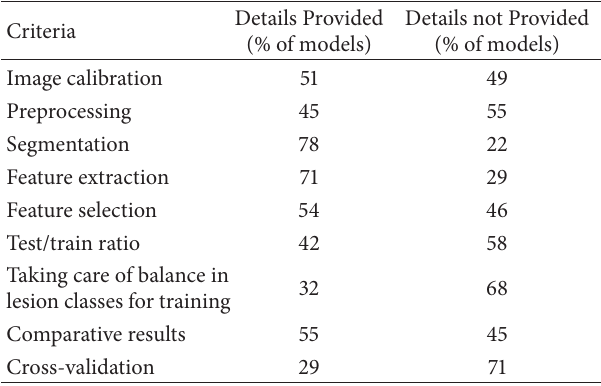
Table 6: Assessment of diagnostic models based on quality assess- ment